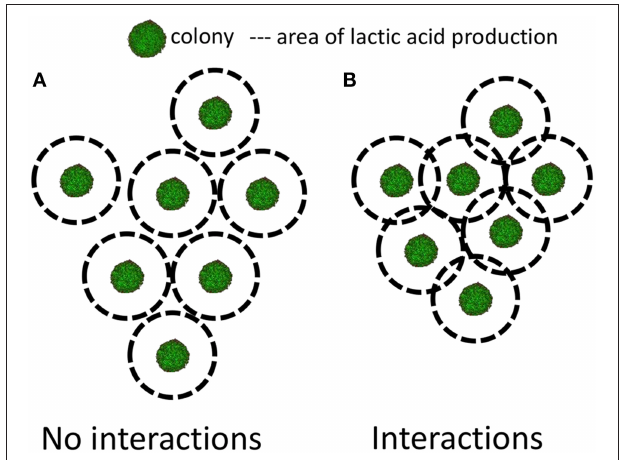
FIGURE 2 | Representation of two situations of neighboring colonies. (A) When the production of lactic acid of one colony does not impact on its neighbors and (B) when the production of lactic acid of one colony does impact on its neighbors. Adapted from Malakar et al. (2002a) and Wimpenny (1992)